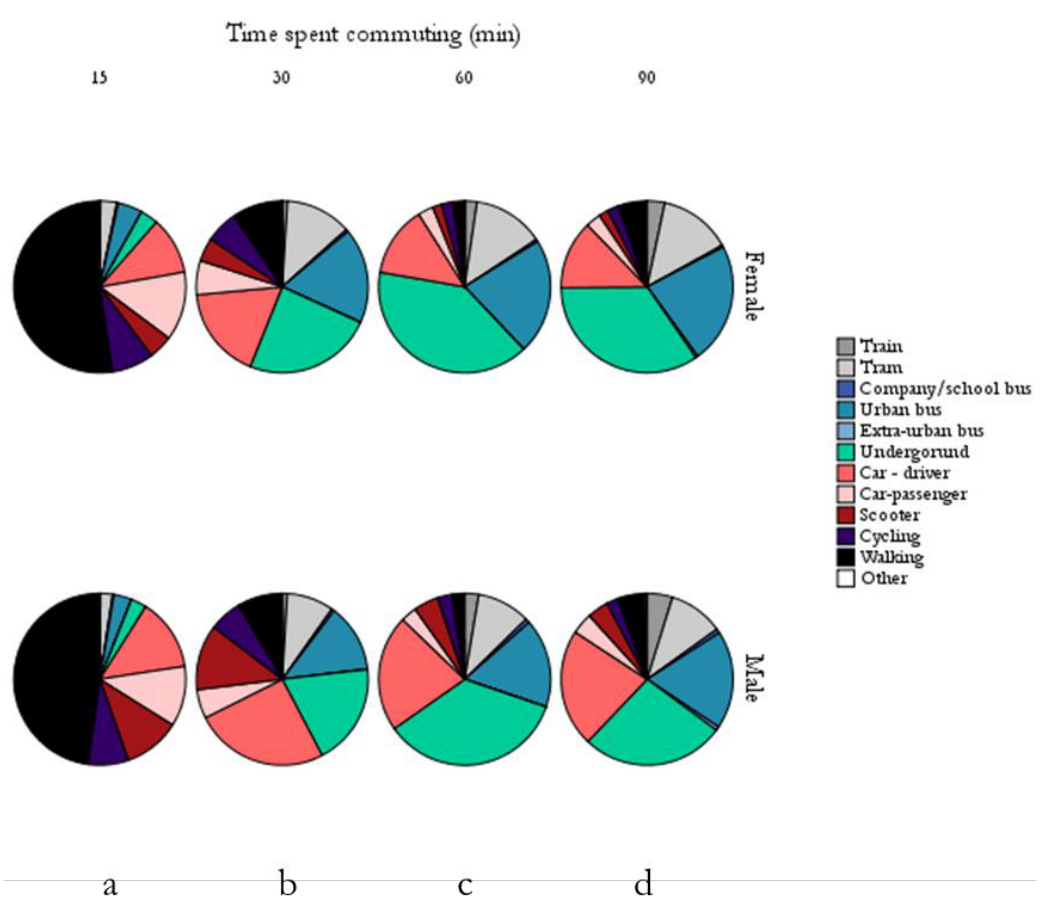
Figure 3. Proportions of subjects who move through different transport MEs within the city of Milan. In the figure, the data are divided by gender (female or male) and by permanence periods (( a ): 15 min, ( b ): 30 min, ( c ): 60 min, ( d ): 90 min).